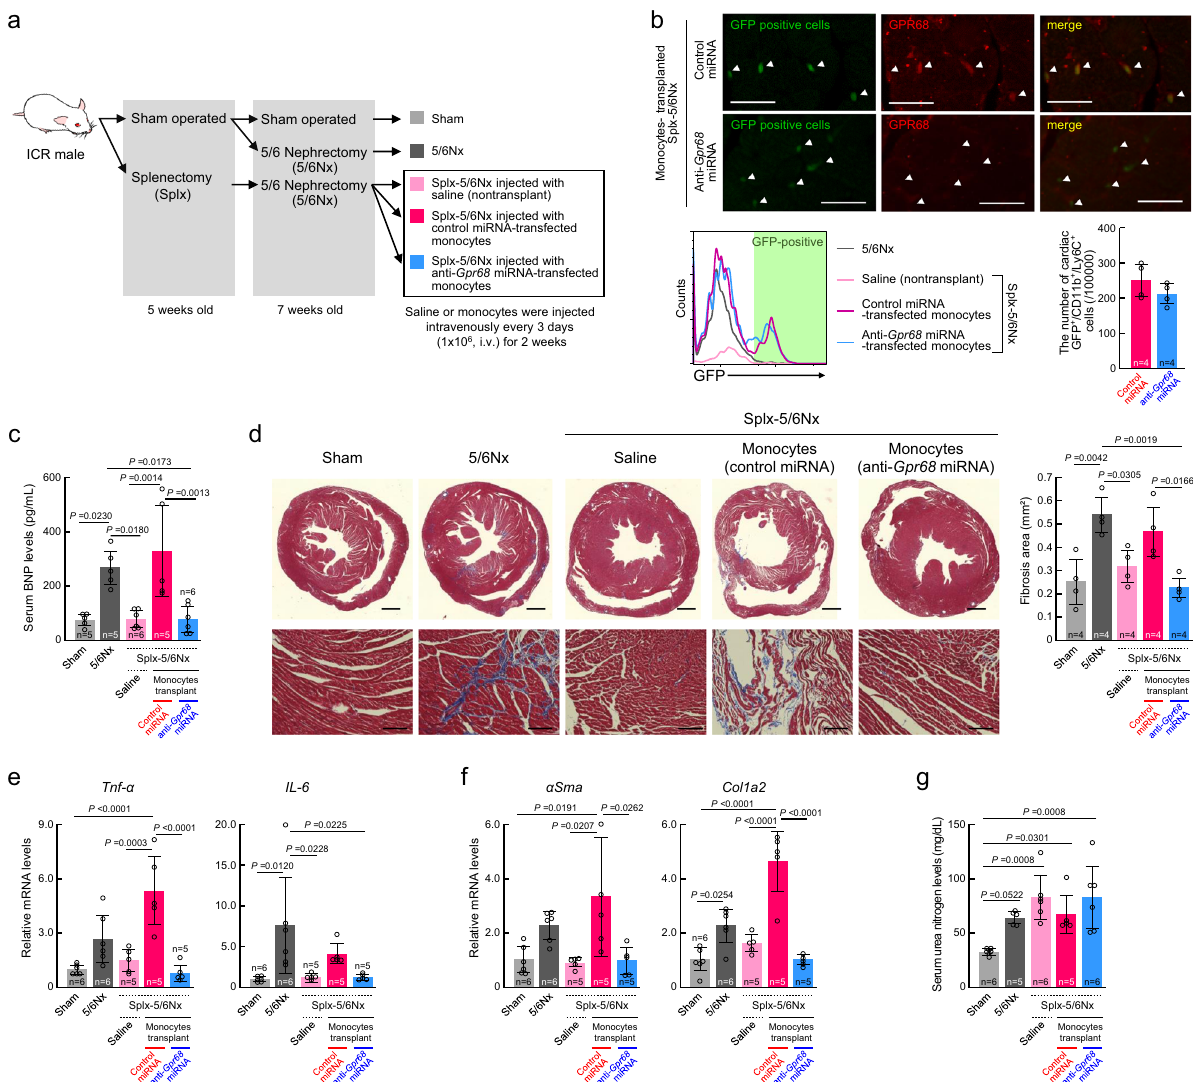
Fig. 4 Role of high-GPR68-expressing monocytes in CKD-induced cardiac in fl ammation and fi brosis. a Schematic experimental procedure for allogeneic transplantation of monocytes into Splx-5/6Nx mice. Monocytes infected with lentivirus-expressing control or anti- Gpr68 miRNA were intravenously injected into Splx-5/6Nx mice every 3 days for 2 weeks after the 5/6 nephrectomy operation. b Upper panels show immuno fl uorescence labeling of GPR68 (red) in the cardiac ventricle slices prepared from Splx-5/6Nx mice at 2 weeks after initiating the injection of monocytes infected with lentivirus-expressing control or anti- Gpr68 miRNA. Green fl uorescence is derived from the lentiviral GFP reporter. The scale bar indicates 20 μ m. Lower panels show the fl ow cytometry histogram of GFP fl uorescence of CD11b + /Ly6C + cells in the heart. GFP-positive cells were detected only in monocyte transplanted mice. c Serum BNP concentrations in Splx-5/6Nx mice at 2 weeks after initiating the injection of control or GPR68-downregulated monocytes. d Downregulation of GPR68 in monocytes ameliorated CKD-induced cardiac fi brosis. The left panel shows Masson ’ s trichrome staining of tissue fi brosis in blue. Scale bars indicate 1 mm (upper panel) and 50 μ m (lower panel). The right panel shows the quanti fi cation of the fi brosis area under light microscopy. e , f The mRNA levels of in fl ammatory cytokines ( Tnf- α and IL-6 ) and fi brosis-related factors ( α Sma and Col1a2 ) in the cardiac ventricle of Splx-5/6Nx mice at 2 weeks after initiating the injection of control or GPR68-downregulated monocytes. g Serum urea nitrogen levels in Splx-5/6Nx mice at 2 weeks after initiating the injection of control or GPR68-downregulated monocytes. For all panels, graphs show the mean ± SD of individual mice in independent experiments. Statistical signi fi cance was determined using one-way ANOVA with Tukey – Kramer post hoc tests ( c – g ). Numbers and P -values are shown in each graph. Source data are provided as a Source Data fi